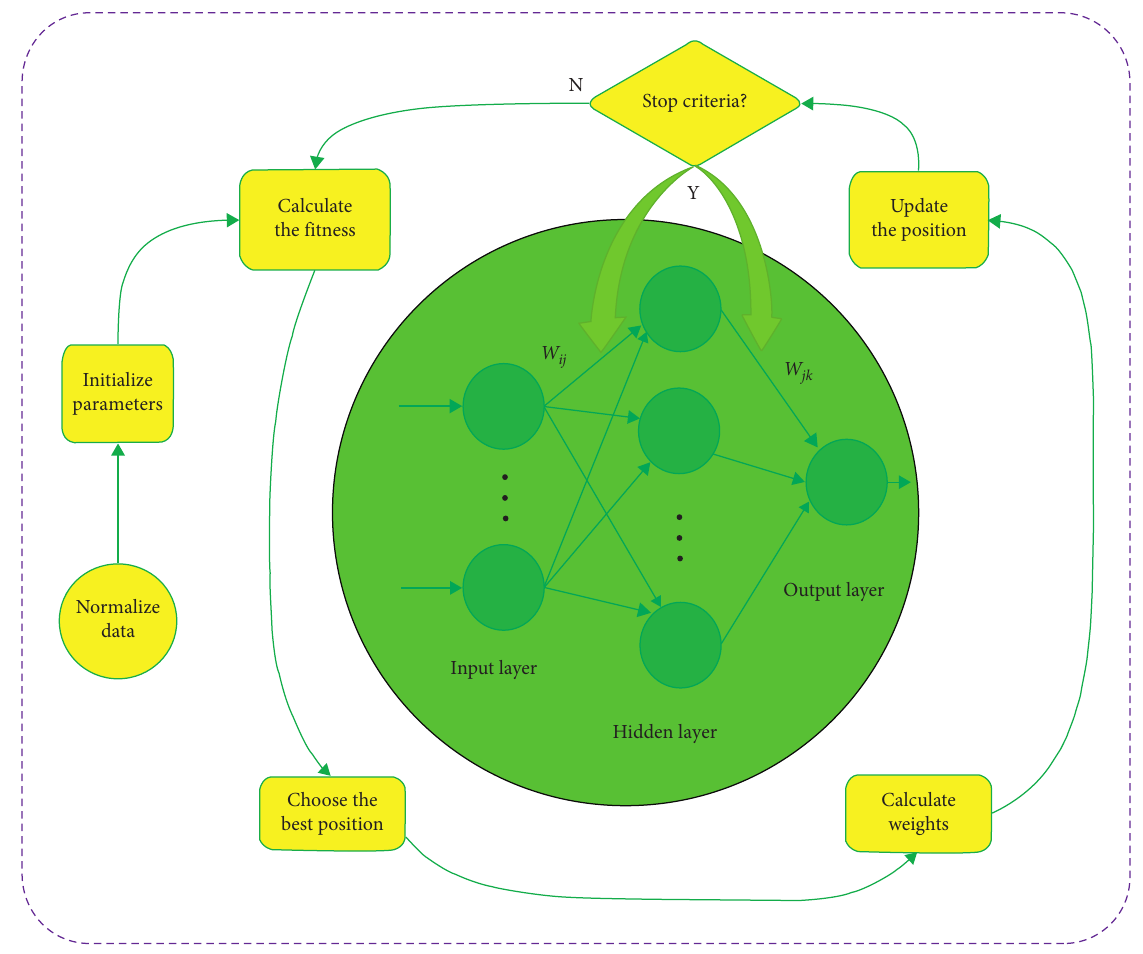
Figure 1: The flowchart of